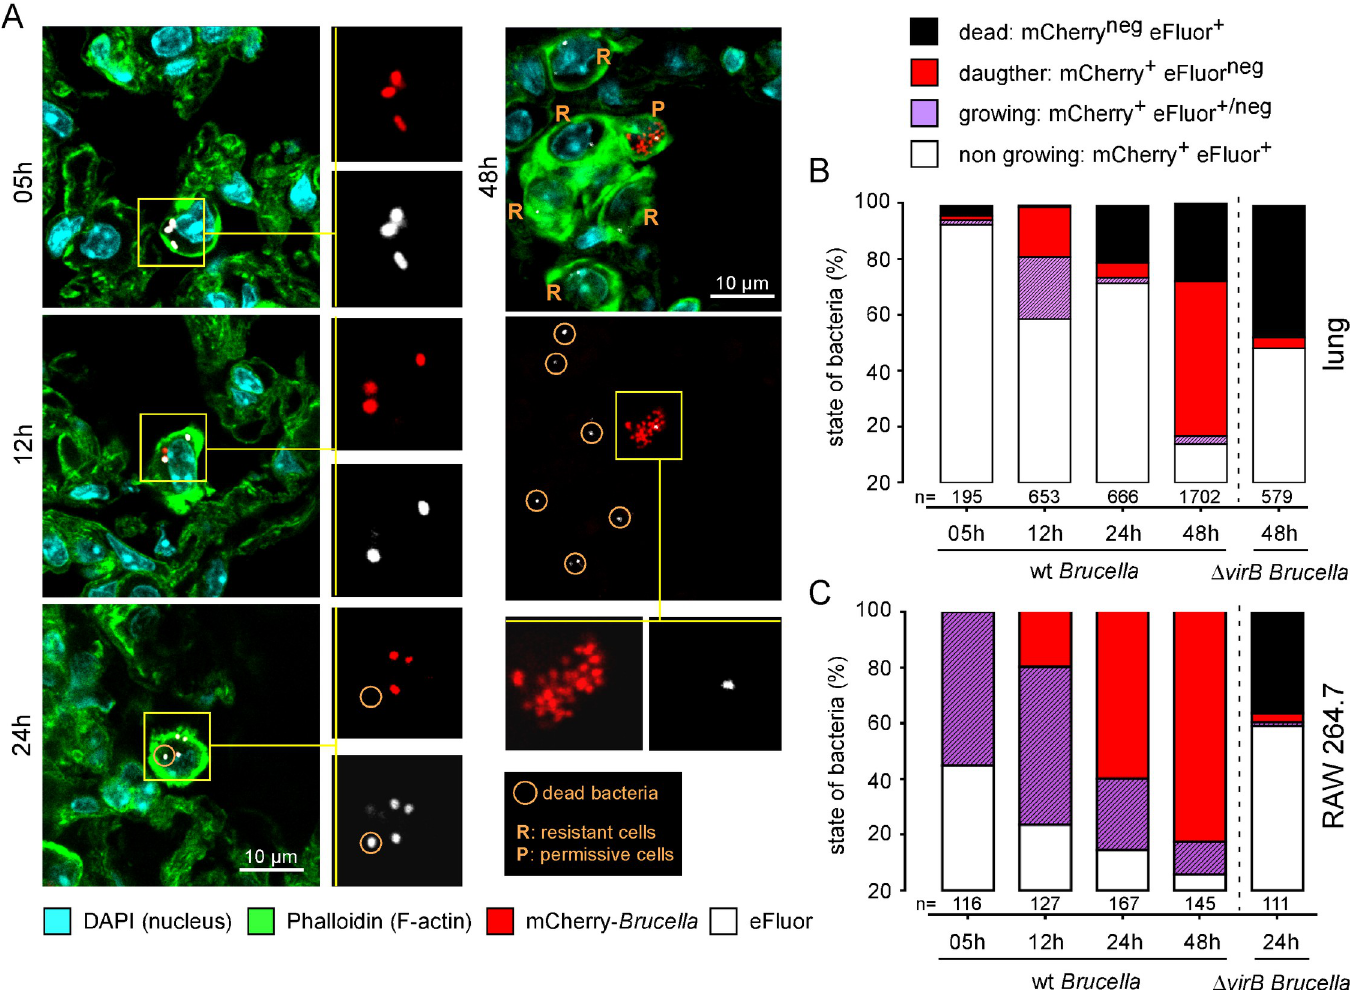
Fig 2. Fluorescent microscopic analysis of B . melitensis multiplication in lungs of wild-type mice and RAW 264.7 macrophages. A, B. C57BL/6 mice (n = 5) were infected with 5x10 6 CFU of mCherry-expressing B . melitensis labelled with eFluor 670 and sacrificed at the indicated time. Lungs were collected and analyzed by fluorescent and confocal microscopy for the expression of DAPI, phalloidin, mCherry and eFluor 670 . Data shown are ( A ) representative confocal images (single z-plane) of infected lungs and ( B ) the frequency of non-growing mother cells, growing mother cells, daughter cells and presumed dead mother cells estimated using a fluorescent microscope (n indicates the number of infected cells observed per group). C. RAW 264.7 macrophages were infected with an MOI of 50 (50 bacteria per cell on average) and analyzed by fluorescent microscopy at the indicated time. Data shown are ( C ) the frequency of non-growing mother cells, growing mother cells, daughter cells and presumed dead mother cells (n indicates the number of infected cells observed per group). These results are representative of two independent experiments.